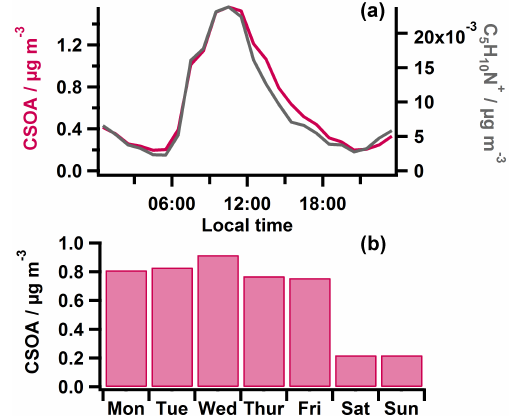
Figure 13. Diurnal cycle of CSOA and the marker fragment C 5 H 10 N + (top) and the weekly cycle (bottom) of CSOA mass con- centrations obtained from HR-AMS data of